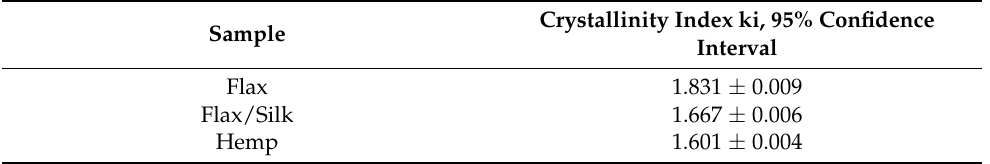
Table 4. Crystallinity index values of bast